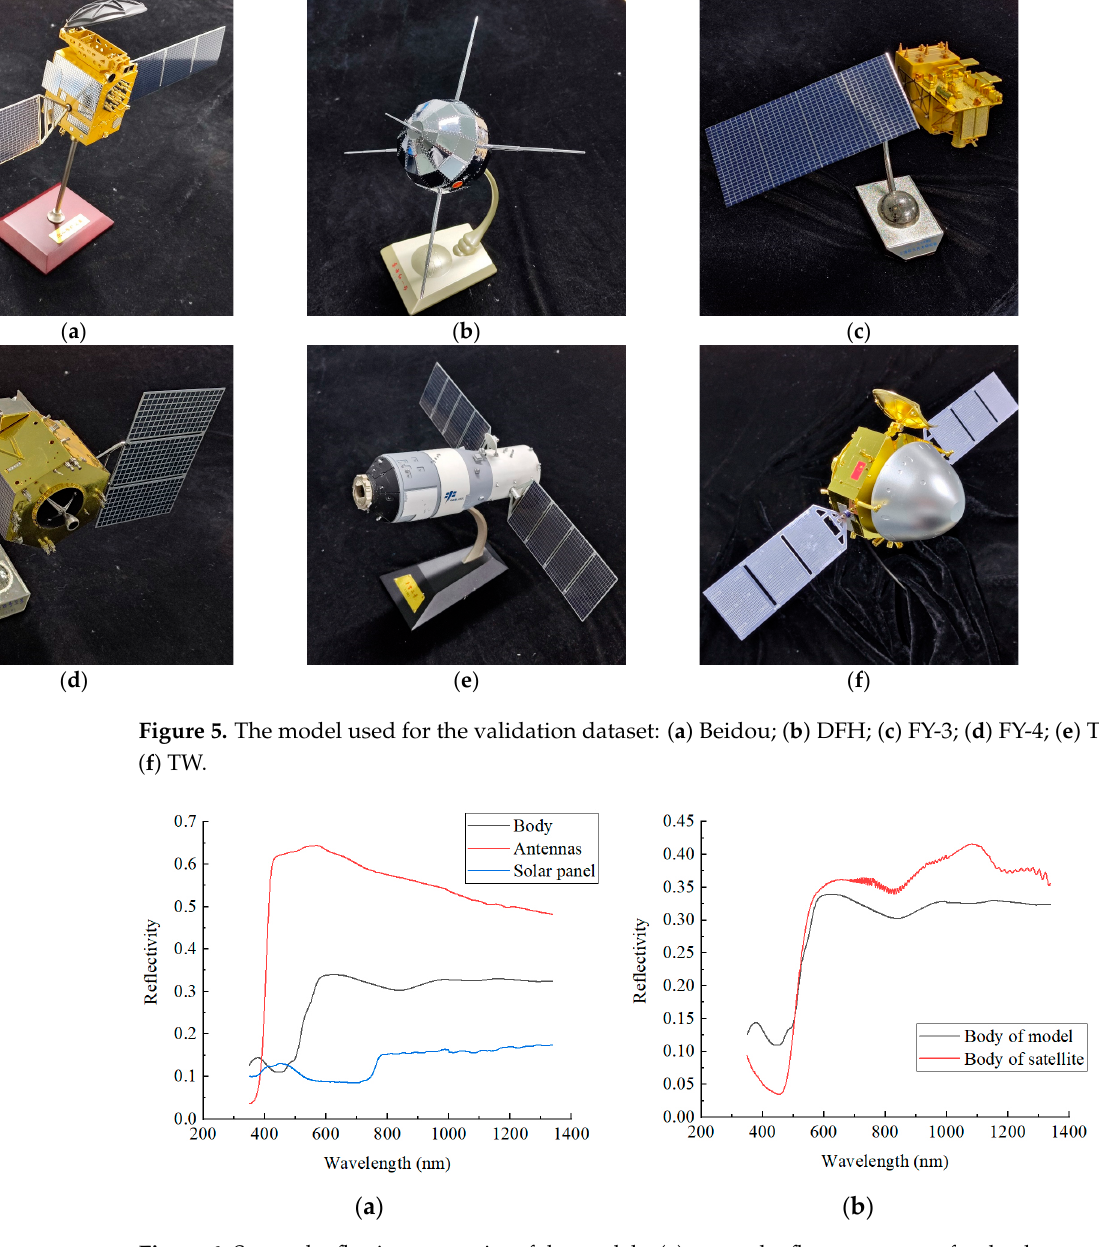
( b ) Figure 7. Environmental simulation equipment: ( a ) solar simulator; ( b ) robot arm. The color temperature of the solar simulator is 6000 K, and the wavelength range is 400–800 nm. We installed the model on the robot arm and obtained space objects images at different positions and attitudes and lighting angles by rotating the manipulator. The layout of solar simulator and robot arm is shown in Figure 8.